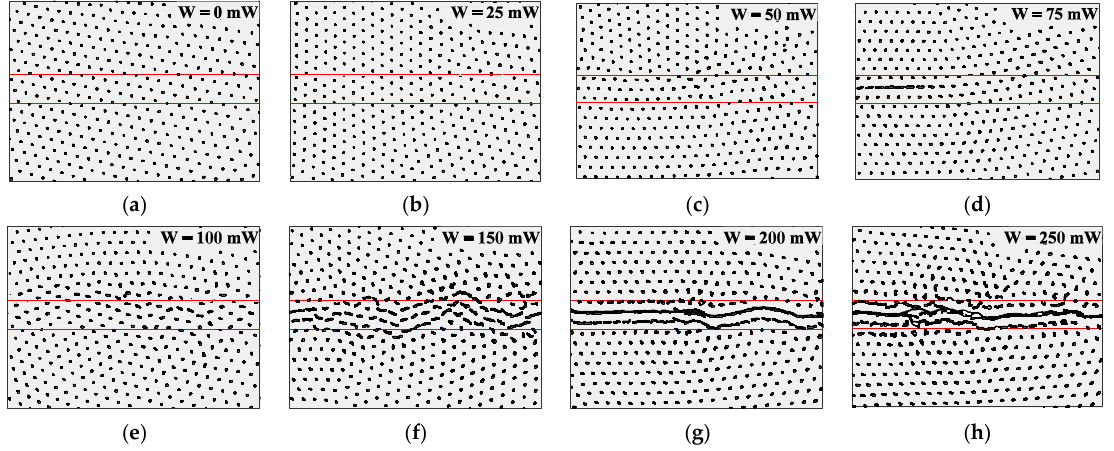
Figure 2. Particle trajectories in the dust structure (Г* = 500), consisting of uncoated MF particles in argon at a pressure of P = 5.3 Pa and a discharge power of W rf = 12.5 W during t = 0.5 s under the action of a pushing laser beam with a width of ~ 4 mm and laser powers of: ( a ) W = 0 mW; ( b ) W = 25 mW; ( c ) W = 50 mW; ( d ) W = 75 mW; ( e ) W = 100 mW; ( f ) W = 150 mW; ( g ) W = 200 mW; ( h ) W = 250